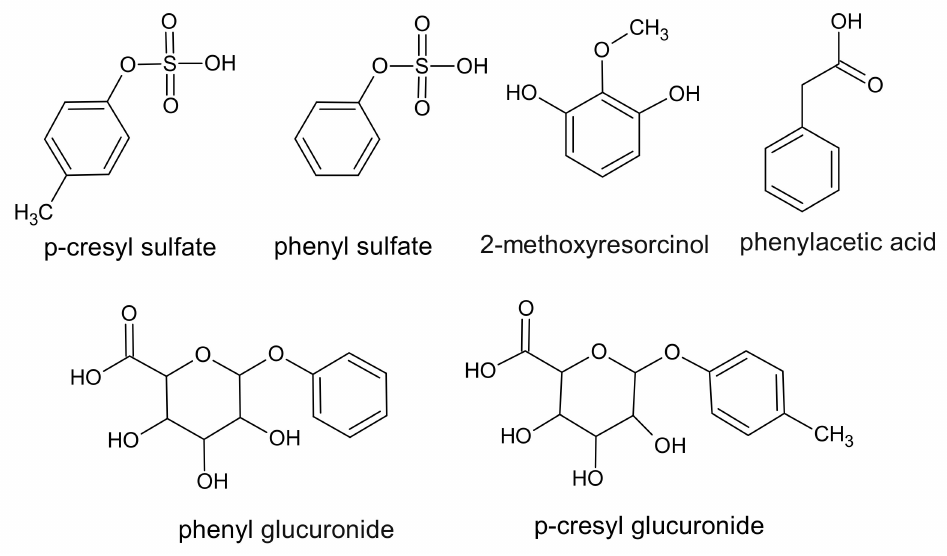
Figure 1. Chemical structure of phenol derivatives, classified as protein-binding uremic